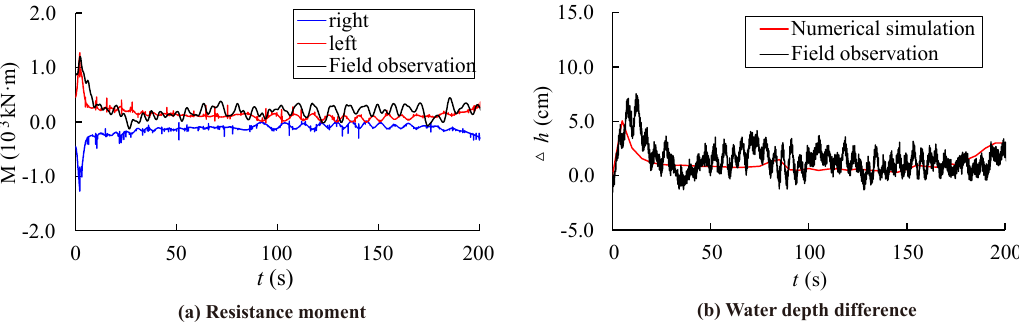
Figure 9. The comparison of the resistance moment and water depth between the numerical model and prototype